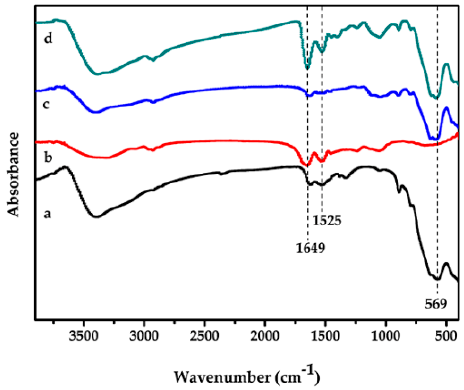
Figure 1. Fourier transform infrared (FTIR) spectra of ( a ) Fe 3 O 4 ; ( b ) cellulase-cross-linked enzyme aggregates (CLEAs); ( c ) 3-aminopropyl triethoxysilane (APTES)-Fe 3 O 4 ; ( d ) magnetic-cellulase-CLEAs.